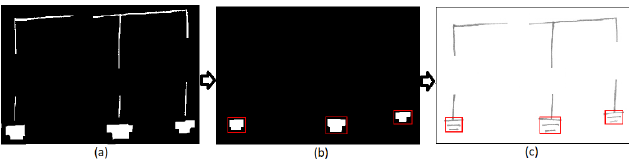
Figure 4. Segmentation of components with connected lines: (a) Image after morphological closing (b) Removal of other components and detection of respective component (c) Localization of component in original image